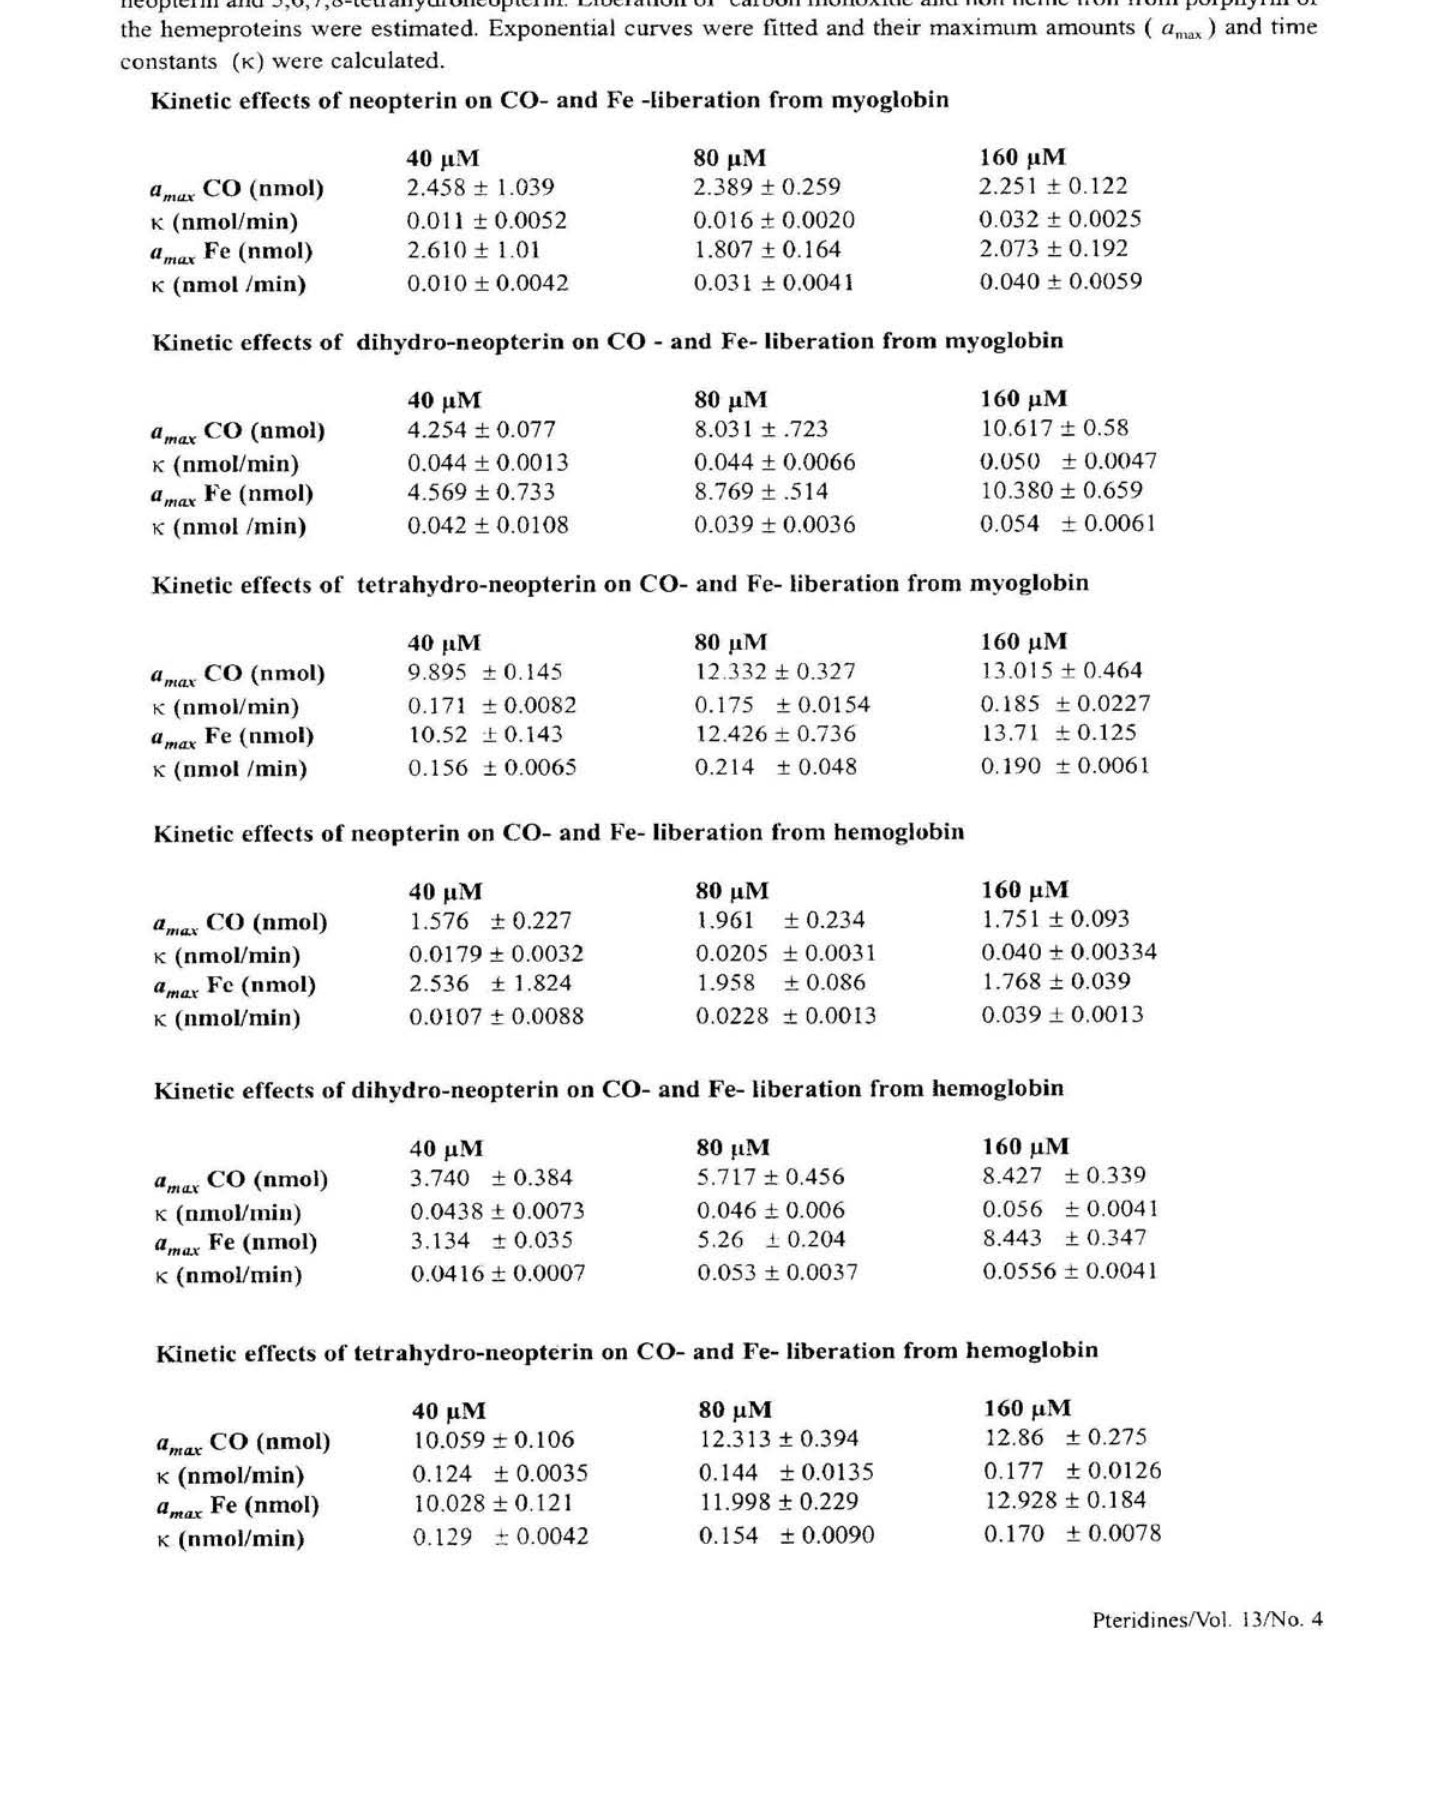
Table 1. Myoglobin and hemoglobin were incubated with different concentrations of neopterin, 7,8-dihydro- neopterin and 5,6,7,8-tetrahydroneopterin. Liberation of carbon monoxide and non heme iron from porphyrin of the hemeproteins were estimated. Exponential curves were fitted and their maximum amounts ( a lndS ) and time constants (κ) were